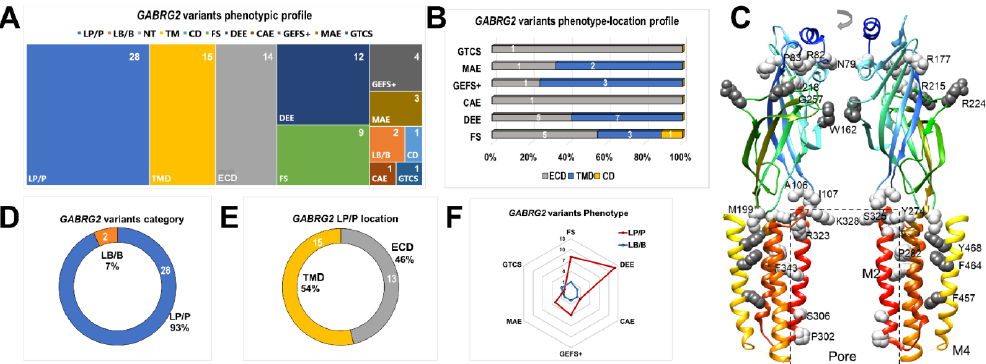
Figure 8. GABRG2 variants contributed to the pathogenesis of FS. ( A ) Comparison of the phenotypic profile of thirty GABRG2 variants reported in this and previous studies (Table 7). GABRG2 variants are grouped by structural domain location (ECD, extracellular domain; TMD, transmembrane domain; and CD, cytoplasmic domain), epilepsy phenotype (FS, febrile seizure; DEE, developmental epileptic encephalopathy; CAE, childhood absence epilepsy; GEFS+, genetic epilepsy with febrile seizures plus; GTCS, generalized tonic-clonic seizure; and MAE, myoclonic-astatic epilepsy), and pathogenicity (LP/P, likely pathogenic/pathogenic; and LB/B, likely benign/benign). The GABRG2 variants’ distribution in each category was assigned a number ranging from 1 to 28. Note that a specific variant may be represented in more than one category. ( B ) Occurrence of thirty GABRG2 variants by structural location (ECD, TMD, and CD) and epileptic phenotype. The number inside the bars corresponds to the variants included in that category. Variants that cause the most complex epileptic phenotypes occur in more than one GABA A R structural domain. ( C ) Side view of the extracellular and transmembrane domains of two opposing γ 2 subunits represented as rainbow ribbons. γ 2 subunit variants are displayed in dark (the present study) and light gray (previously reported). In addition, key structural domains are indicated. ( D , E ) Doughnut plots classify GABRG2 variants by pathogenicity (LP/P, n = 28, and LB/B, n = 2) and structural location (NT, n = 13, and TM, n = 15, LP/P only), respectively. The plots show most variants are pathogenic, localizing preferentially to two key receptor activation domains. ( F ) Spider diagram comparing the pathogenicity and type of epilepsy profile of GABRG2 variants. The features of the thirty GABRG2 variants are summarized in Table